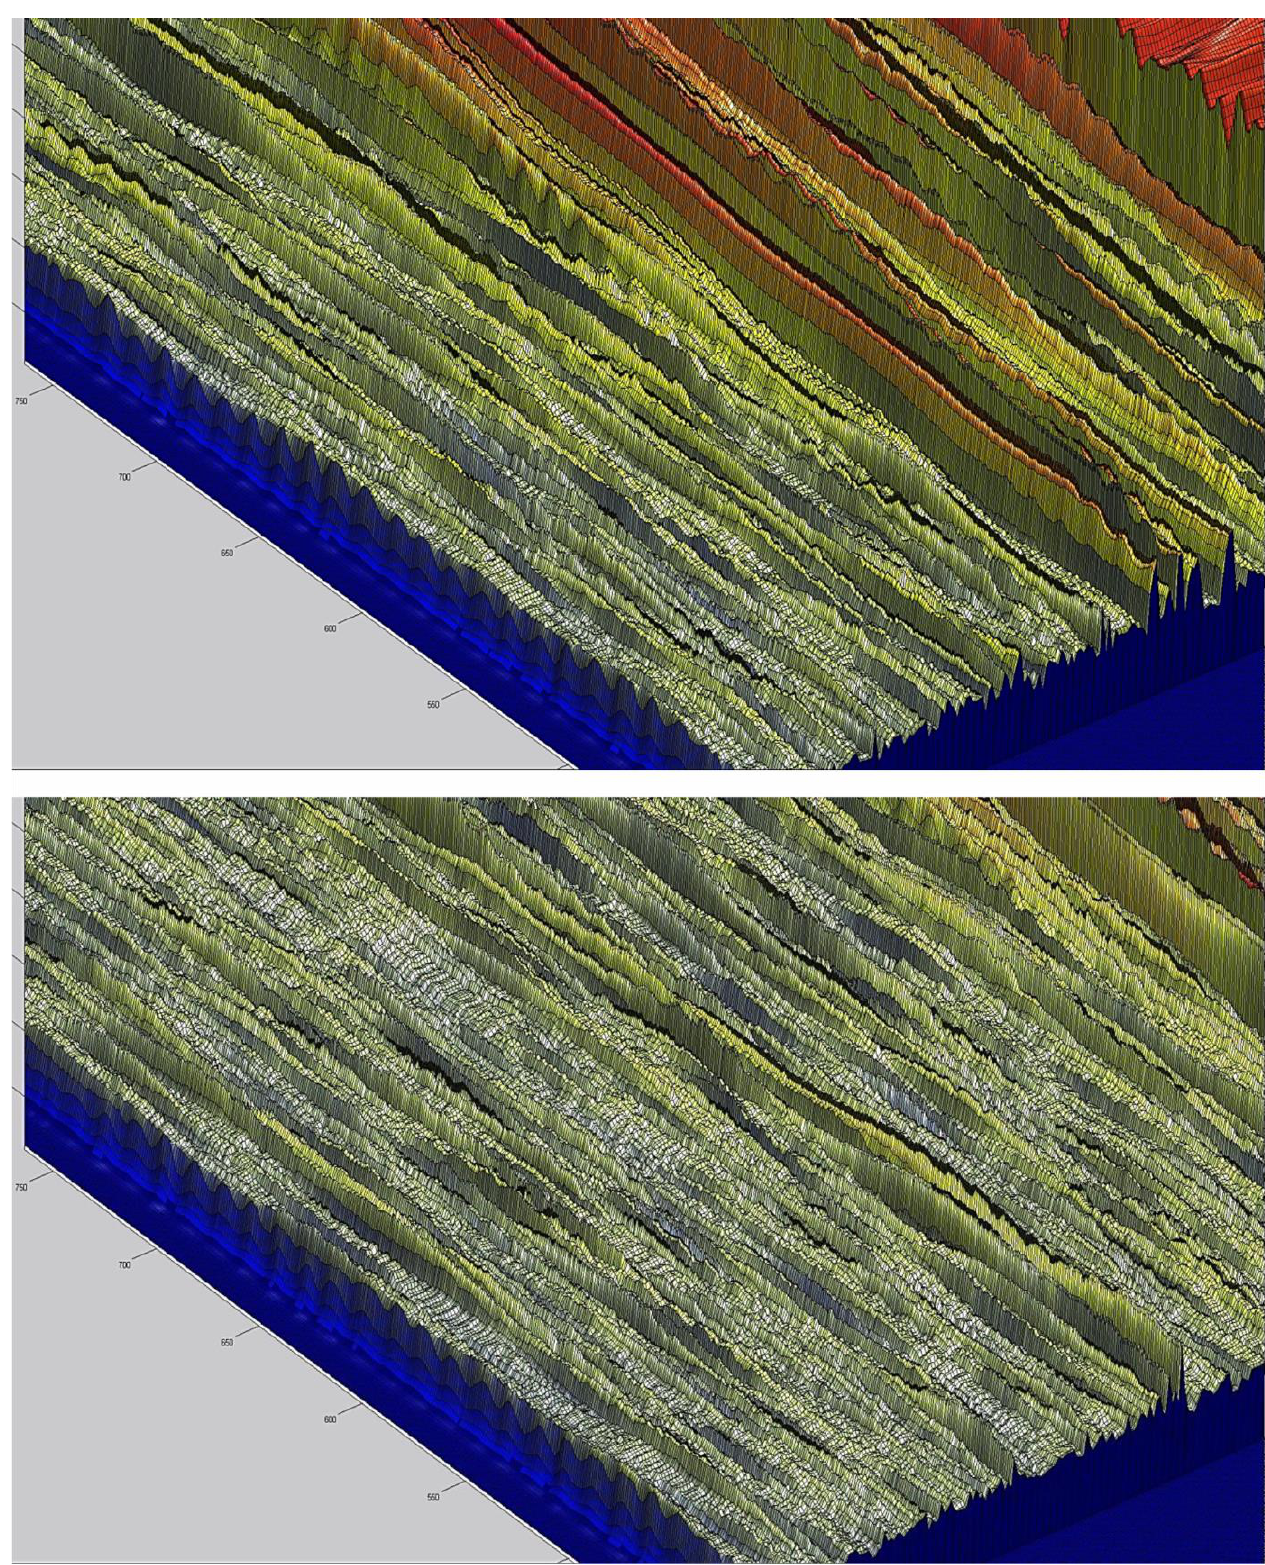
Figure 3. Images of the topography of the machined surface during grinding of planes with a traverse feed of 0.3 mm; after two — traverse feeds-top image, after three — traverse feeds-bottom image.